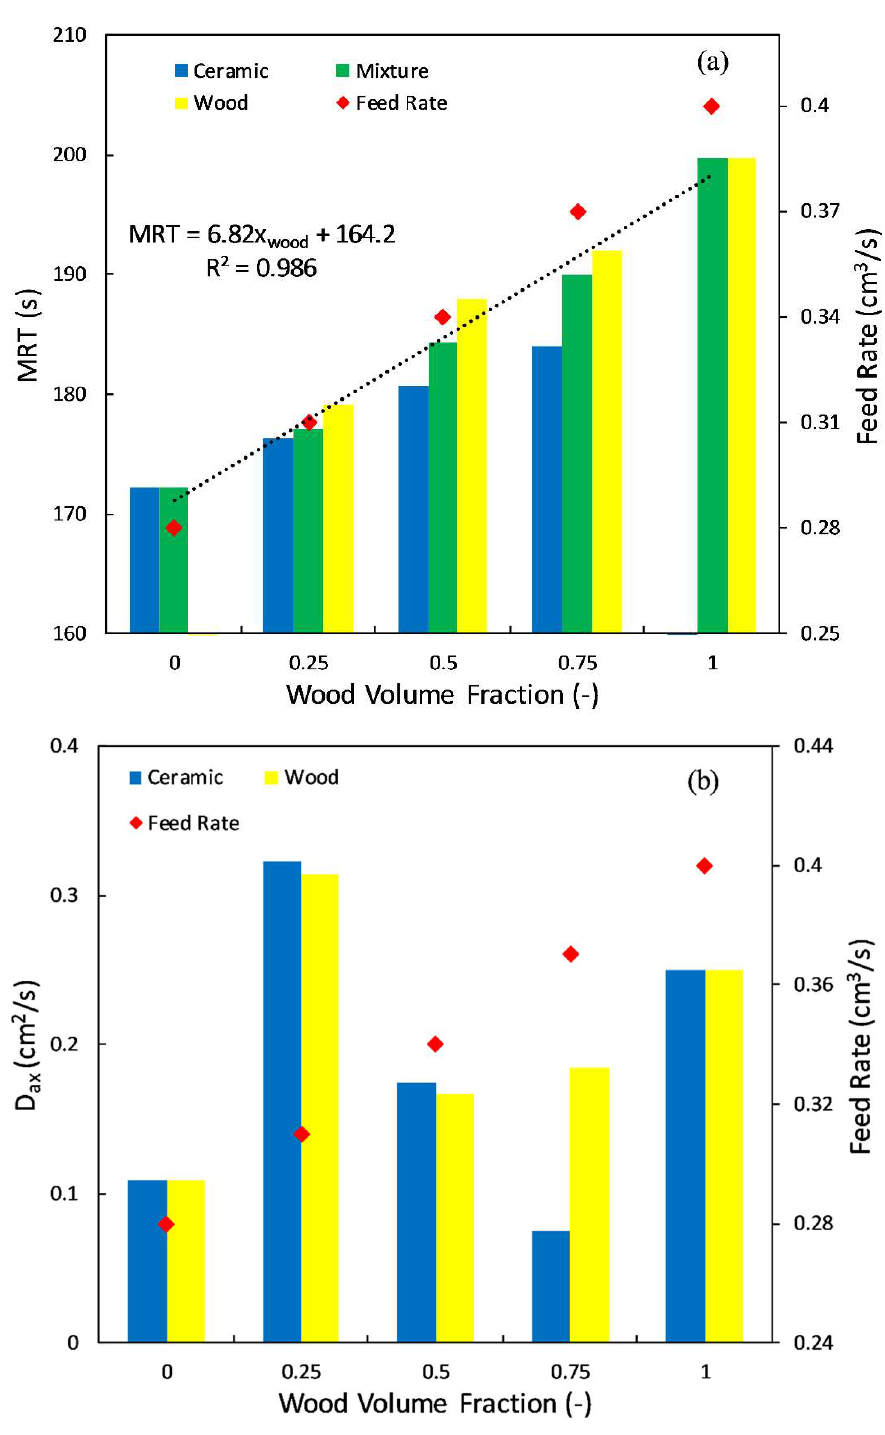
Figure 10 . Effect of volume fraction of light (wood) and heavy (ceramic) cuboid particles on ( a ) the MRT ( b ) the axial dispersion coefficient at 7 rpm and 2°.